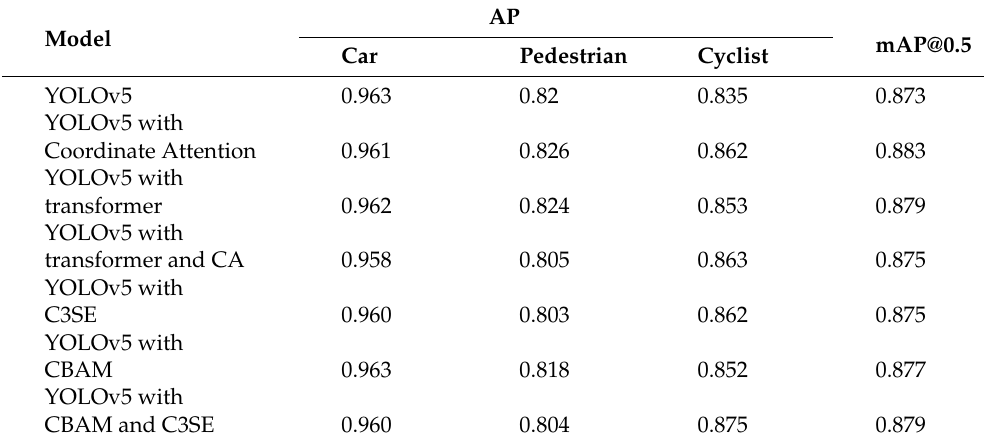
Table 2. The recognition results of YOLOv5s with different attention mechanisms in KITTI dataset.